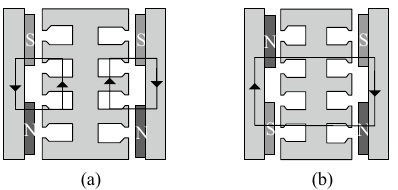
Figure 5 Magnetic circuit type of a torus-S motor: a NN and b NS type